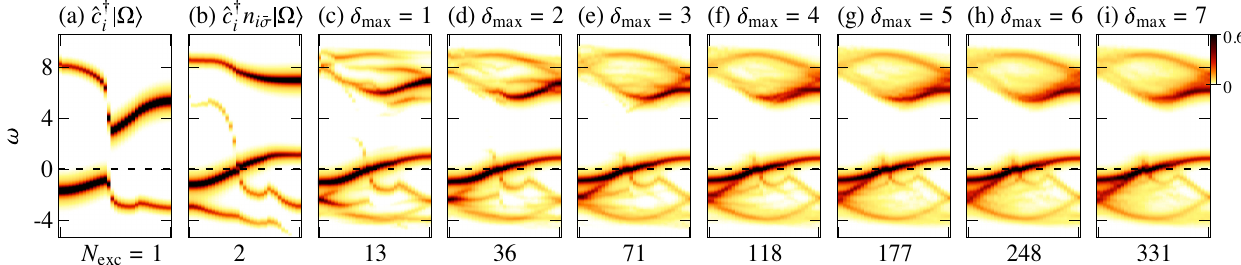
FIG. 8. Comparison of spectral weight for the 64-site 1D Hubbard model in the Mott insulating state, as shown in Fig. 2(c), but considering only a subset of excitations. Indeed, in Fig. 2(c), we consider up to a threshold δ δ 7 in panel (i), δ 6 in panel (h), and so on. Panel (b) plots the case where the first two (local) excitations of Eq. (18) are taken max ¼ max ¼ into account, and panel (a) is the case taking into account only the first one, i.e., the trivial excitation. Note that the labels in the k axis are the same as in Fig. 2(c), so they have been omitted here.